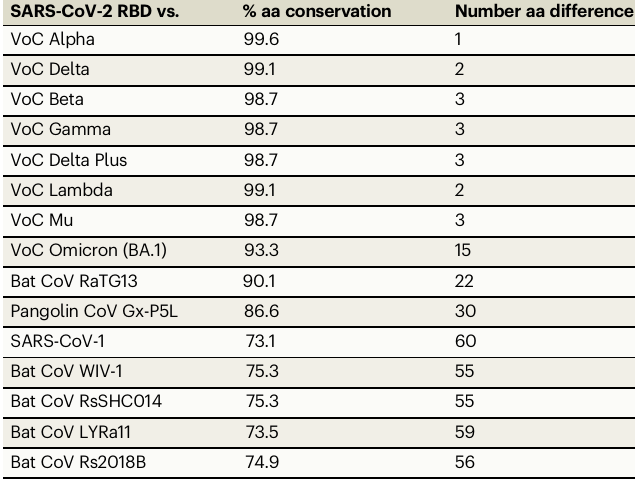
Table 2 | RBD amino acid sequence homology versus ances- tral SARS-CoV-2 SARS-CoV-2 RBD vs.